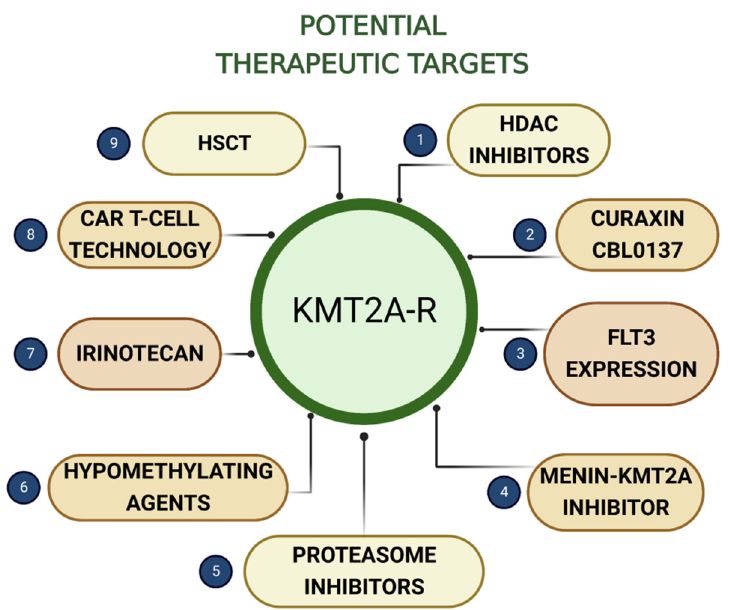
Figure 3. KMT2A -r ALL—potential therapeutic targets discussed in the review. HDAC—histone deacetylase; FLT3—fms-like tyrosine kinase 3; CART T-cell—chimeric antigen receptor T-cell; HSCT—hematopoietic stem cell transplantation